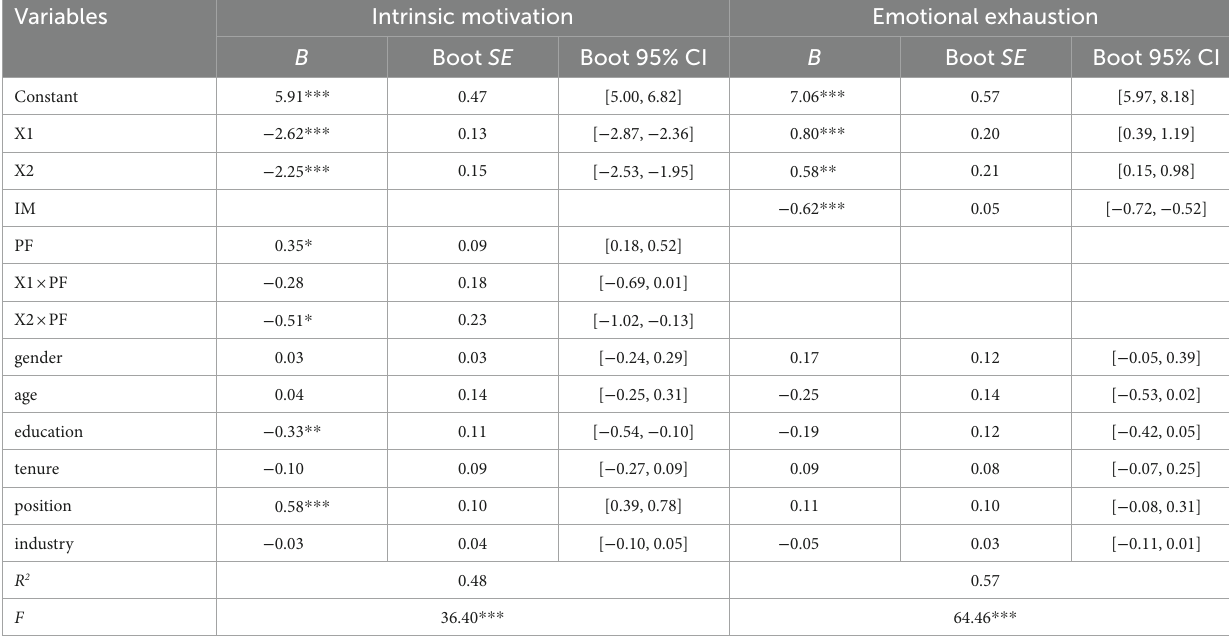
TABLE 2 Regression coefficient estimates in Study 1 with control group as referent group.